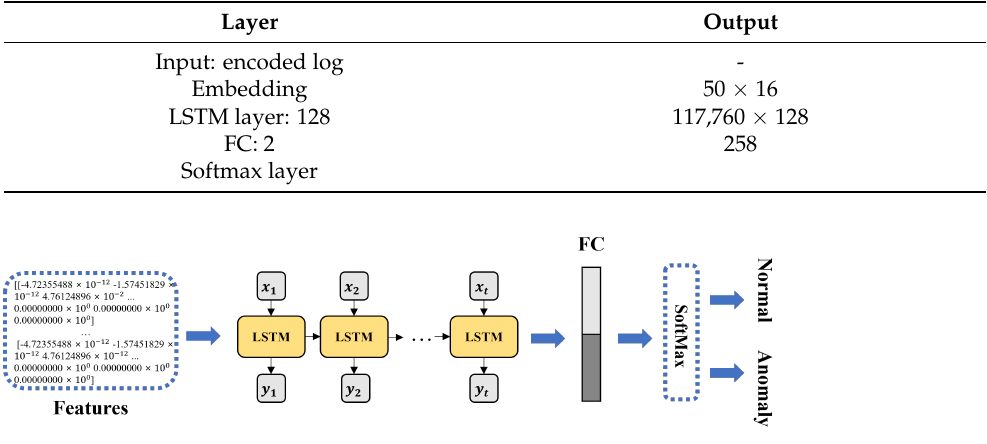
Figure 4. LSTM-based log anomaly detection model